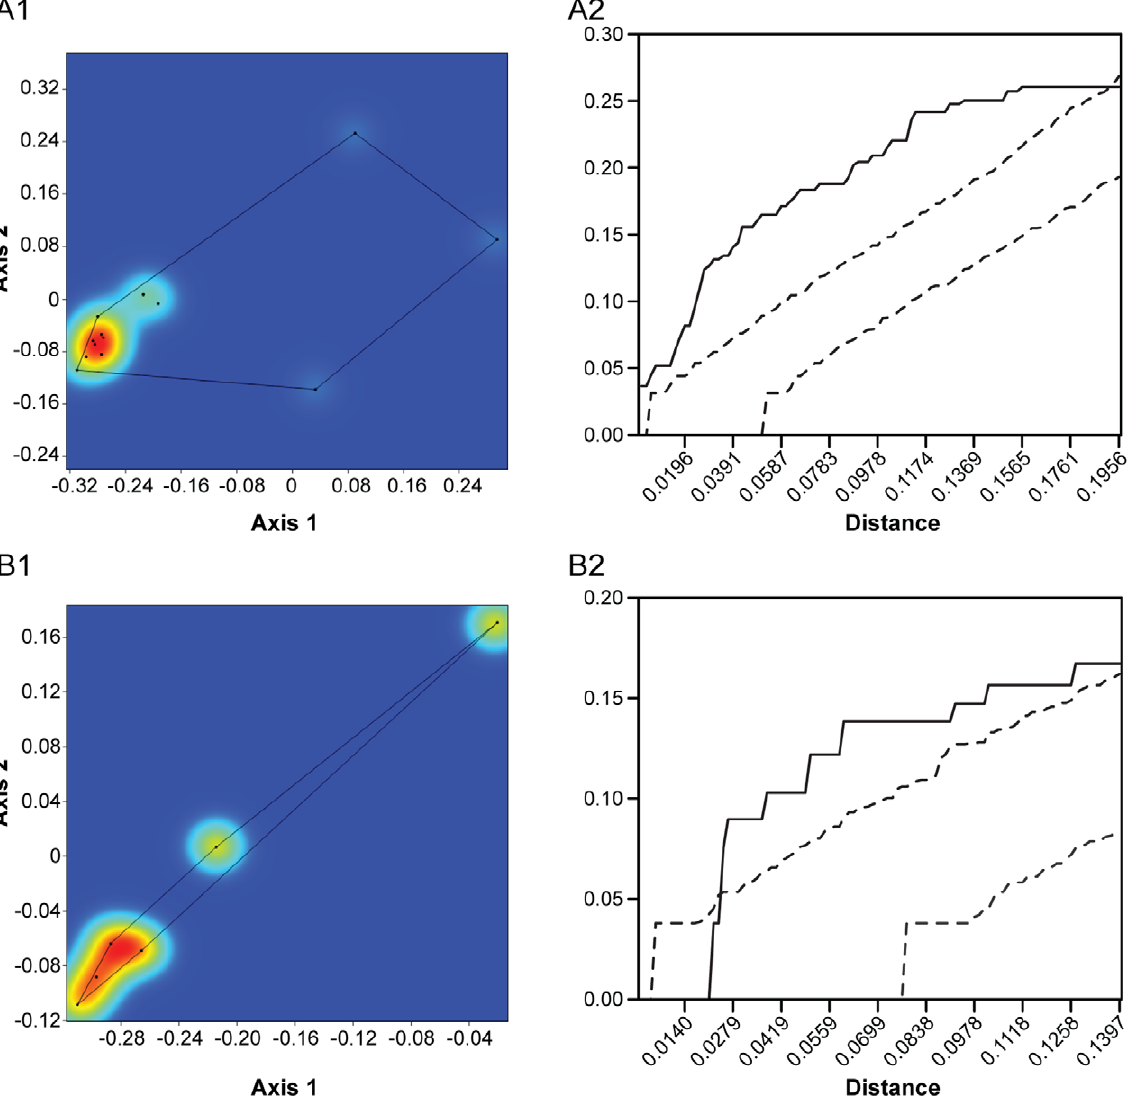
Figure 5. Kernel density and Ripley’s K plots of large carnivorans for the final two time slices studied here. A. 2 – 1.5 Ma; B. Extant fauna. Note markedly different scales between these plots and between plots in Figures 4 and 5. For further discussion, see